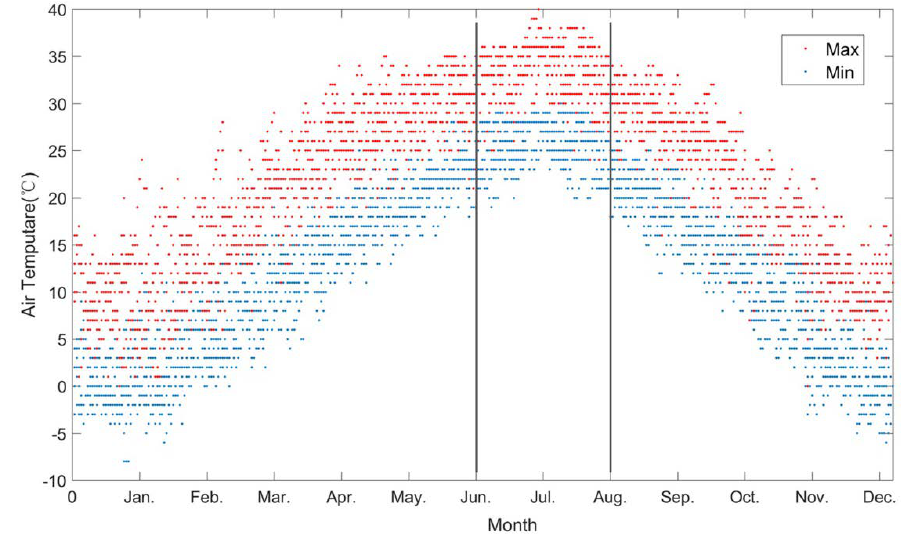
Figure 2. The date range of the air temperature collected from 2011 to 2017. The red dots represent the daily maximum temperatures, while the blue dots represent the daily minimum temperatures.